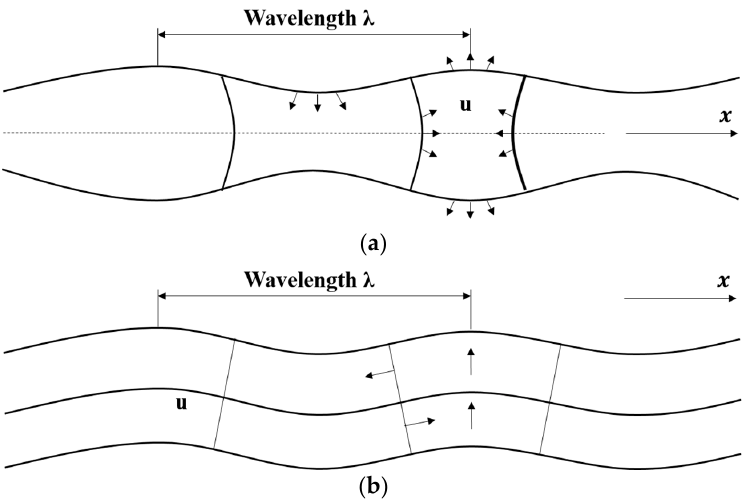
Figure 2. Mode shapes of symmetric (S0) and antisymmetric (A0) fundamental Lamb wave modes. ( a ) Symmetric mode; ( b ) antisymmetric mode. Materials 2016 , 9 , 437